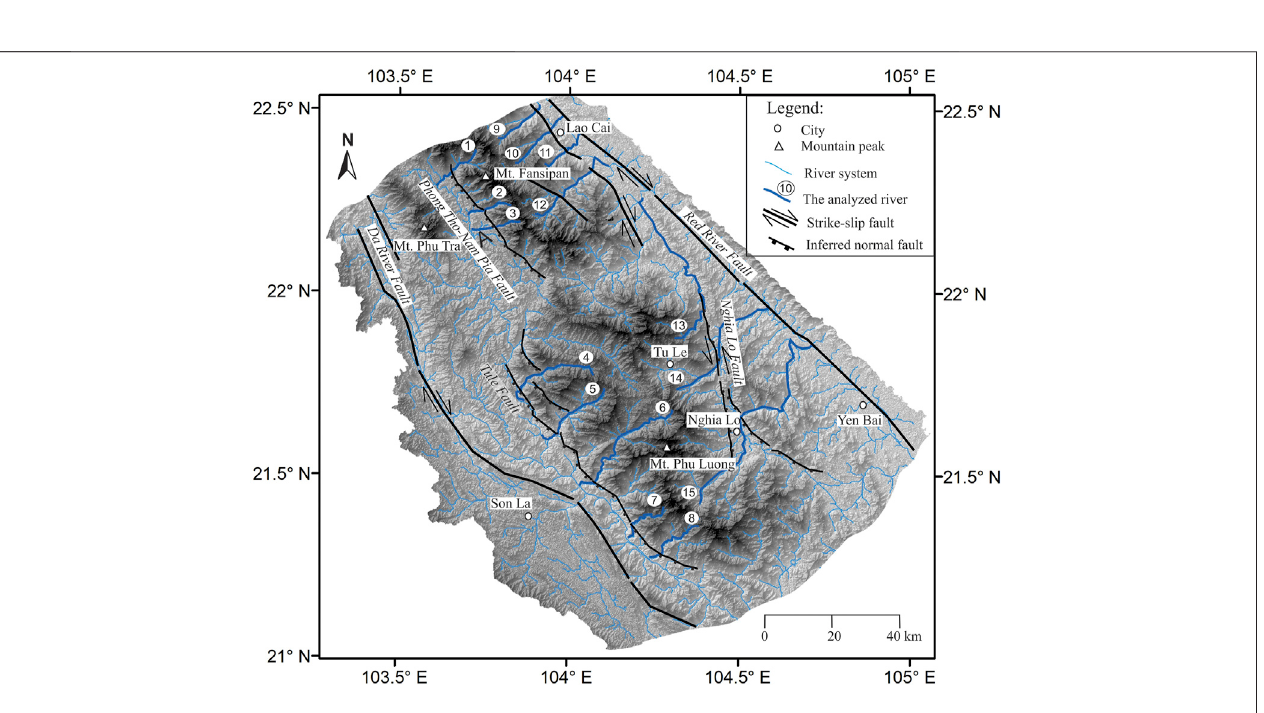
FIGURE10| Topographicmapshowingthedistributionofmajorfaults(blacklines)withintheFansipanandTulemountainrangesandadjacentareas.Thethinblue linesshowtheriversystems.Thethickbluelineshowstheriversusedfortheriverpro fi leandnormalizedsteepnessindexanalyses.Thenumberbeforetheriverlabelsthe name of the analyzed